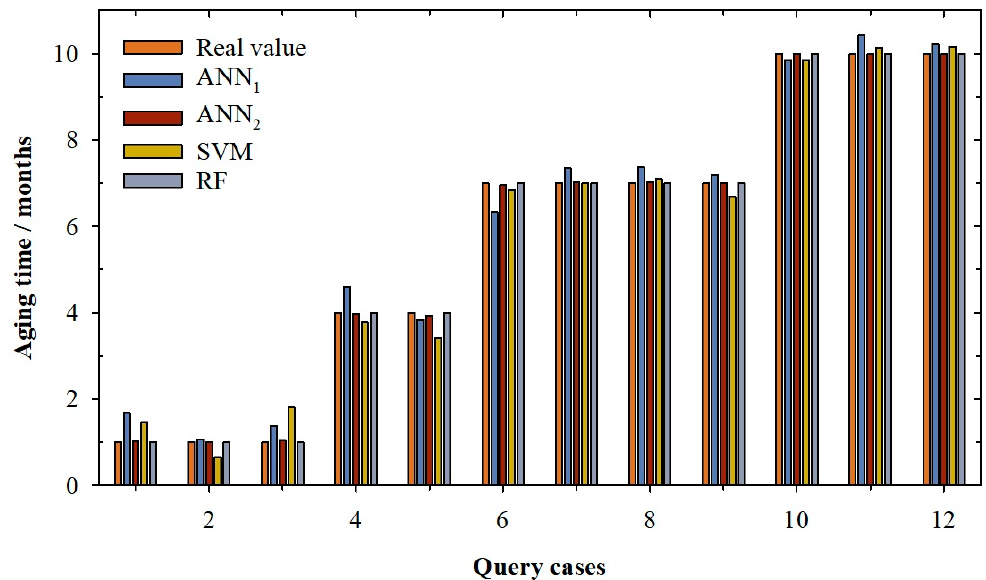
Figure 2. Bar graph for querying cases according to the real value of aging time (light brown) and the values predicted by the artificial neural network with linear function in output neuron (ANN 1 , dark blue), artificial neural network with sigmoidal function in output neuron (ANN 2 , dark brown), support vector machine (SVM, olive) and random forest (RF, light blue).